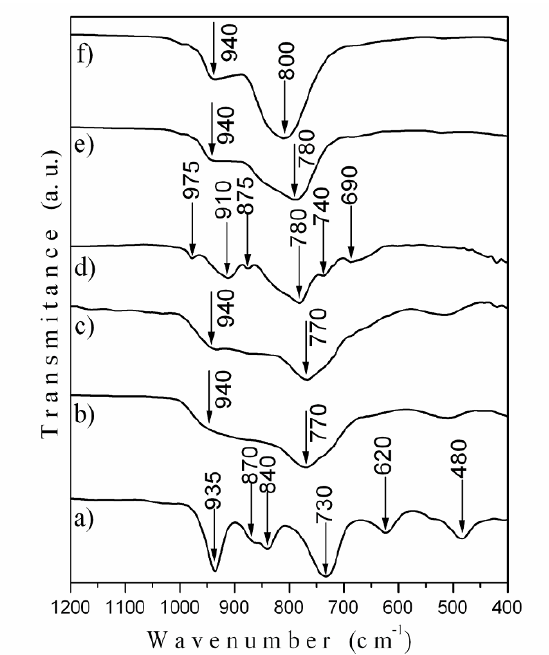
heat-treatment at: a) 100 o C; b) 200 o C; c) 300 o C; d) 400 o C; e) 450 o C; f) 600 o C.